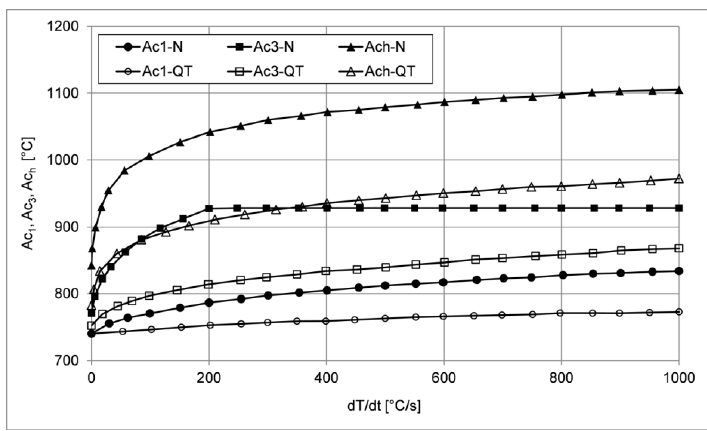
Figure 2 . Rate-dependent temperatures and PM-dependent Ac 1 , Ac 3 , and Ac h for N- and QT-type workpieces (Sente Software Ltd. [13]).